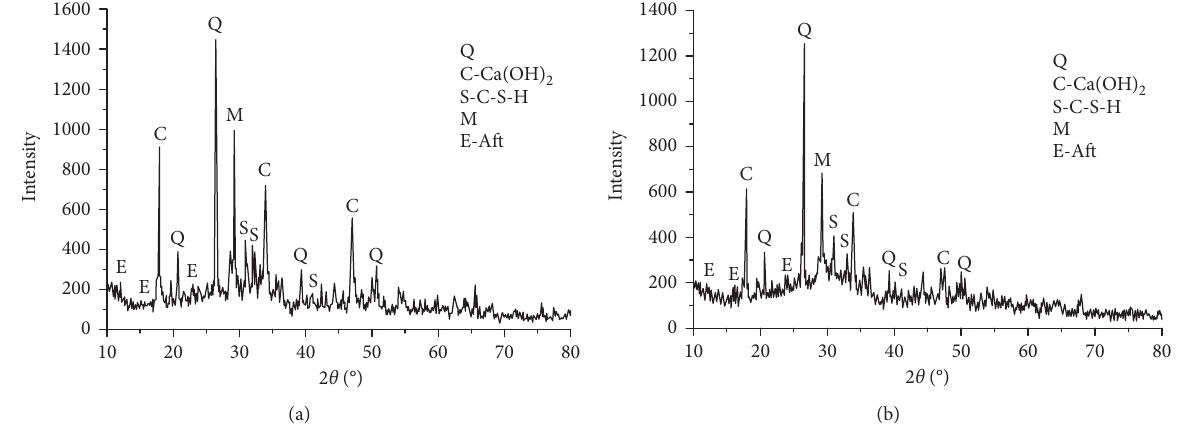
Figure 7: XRD patterns of hydration products with 50% fly ash and activator at different ages. (a) 3-day hydration; (b) 28-day